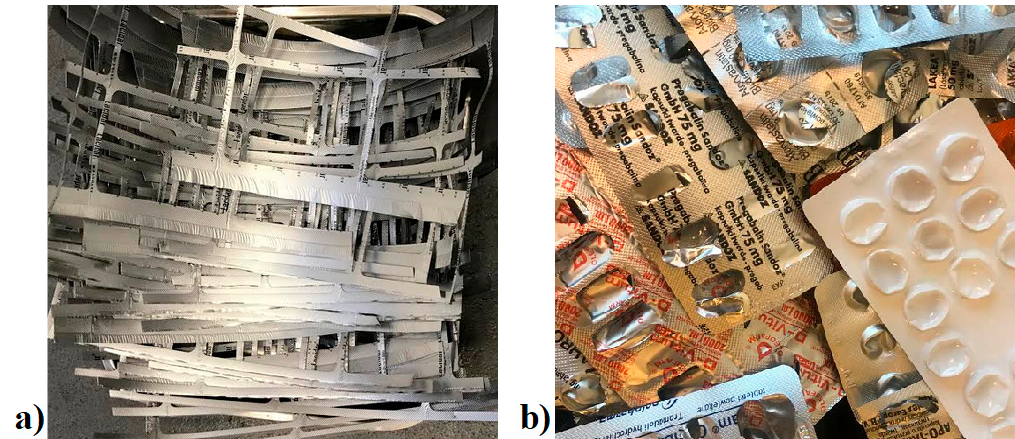
Figure 1. Analyzed materials; ( a ) preconsumer waste, ( b ) postconsumer waste.